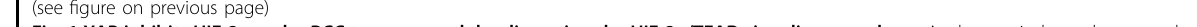
Fig. 1 YAP inhibits HIF-2 α and ccRCC tumor growth by disrupting the HIF-2 α /TEAD signaling complex. a Anchorage-independent growth of 786-O cells treated with vehicle or XMU-MP-1 at the indicated concentrations. b , c Growth curves ( b ) and images ( c ) of 786-O xenograft tumors treated with vehicle or XMU-MP-1 for 33 days. n = 7 mice for each group. d Anchorage-independent growth of 786-O cells expressing Tet-O-YAP5SA and treated with vehicle or Doxycycline. e , f Growth curves ( e ) and images ( f ) of Tet-O-YAP5SA-expressing 786-O xenograft tumors treated with vehicle or Doxycycline. n = 6 mice for each group. g , h Protein levels of HIF-2 α and YAP as well as levels of YAP phosphorylation on S109 and S127 were analyzed by the indicated antibodies ( g ) and relative mRNA levels of GLUT1 , VEGFA , and PGK1 were determined by RT-qPCR ( h ) in 786-O cells treated with XMU-MP-1 at the indicated concentrations. i , j Protein levels of YAP and TAZ ( i ) and relative mRNA levels of GLUT1 , VEGFA , and SERPINE1 ( j ) in 786-O cells treated with the indicated siRNAs in the absence or presence of 2 μ M XMU-MP-1. Of note, the anti-YAP antibody recognized both YAP and TAZ on Western blot (WB). k Gene set enrichment analysis (GSEA) of RNA-seq data shows a depletion of HIF-2 α target genes in 786-O cells treated with 2 μ M XMU-MP-1. l Volcano plot shows the opposite effects of XMU-MP-1 treatment (2 μ M) on HIF-2 α target genes and the Hippo pathway signature genes in 786-O cells. m Relative mRNA levels of VEGFA and GLUT1 in 786-O cells expressing the indicated YAP constructs. n Relative mRNA levels of the indicated genes in 786-O cells treated with the control (siNC) or two independent TEAD4 siRNAs (siTEAD4-1 and siTEAD4-2). o Relative mRNA levels of VEGFA and GLUT1 in 786-O cells infected with or without TEAD4 lentivirus and treated with or without XMU- MP-1. p Co-IP experiment showing that HIF-2 α forms a complex with TEAD4 in 786-O cells. q ChIP experiments showing that TEAD4 (but not YAP) and HIF-2 α co-occupied on the promoter/enhancer regions of HIF-2 α target genes while TEAD4 and YAP co-occupied on the promoter/enhancers region of a YAP target gene CTGF . r ChIP experiments showing that TEAD4 knockdown reduced HIF-2 α binding to its target promoters/enhancers. s Co-IP experiment showing that treating 786-O cells with XMU-MP-1 reduced HIF-2 α binding while increased YAP binding to TEAD4. Immunoprecipitates by IgG or anti-TEAD4 antibody (top) and cell extracts (bottom) were analyzed by WB with the indicated antibodies. t ChIP experiments showing that treating 786-O cells with XMU-MP-1 decreased HIF-2 α binding to its target promoters/enhancers. u Model for how Hippo/ MST1/2 inhibition or YAP activation inhibits HIF-2 transcriptional activity and ccRCC tumor cell growth (see text for details). Data in h , j , m , n , o , q , r , t are means ± SD. * P < 0.05, ** P < 0.01, *** P < 0.001 (two-sided, unpaired t